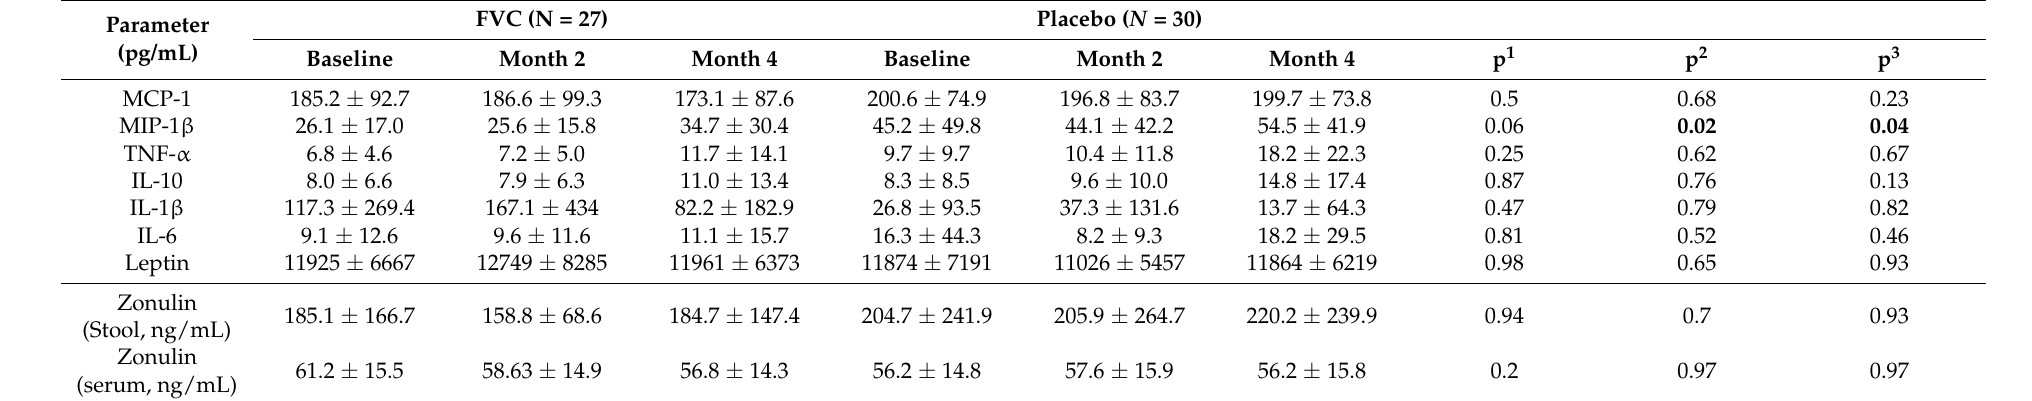
Table 4. Immune and intestinal health parameters for FVC vs. Placebo at baseline, month 2 and 4.